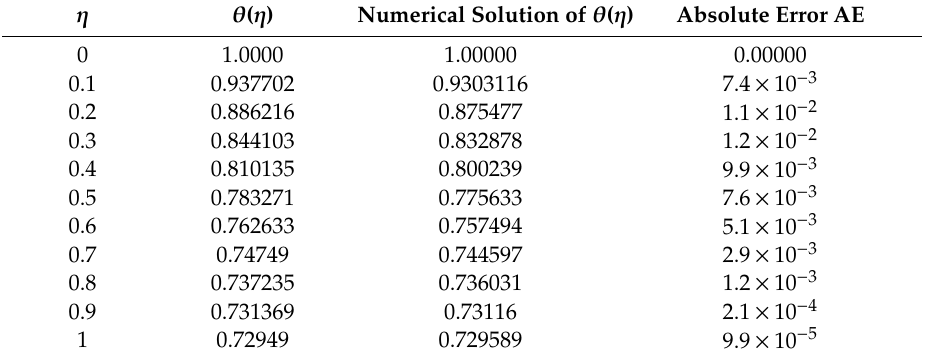
Table 6. Association between Homotopy Analysis Method (HAM) and Numerical techniques for θ ( η )